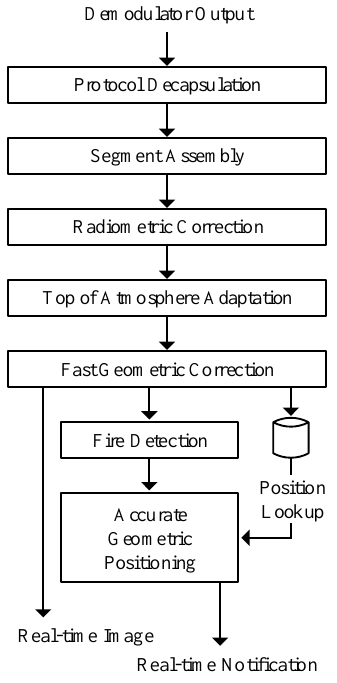
Figure 1. Process flow of stream-based processing